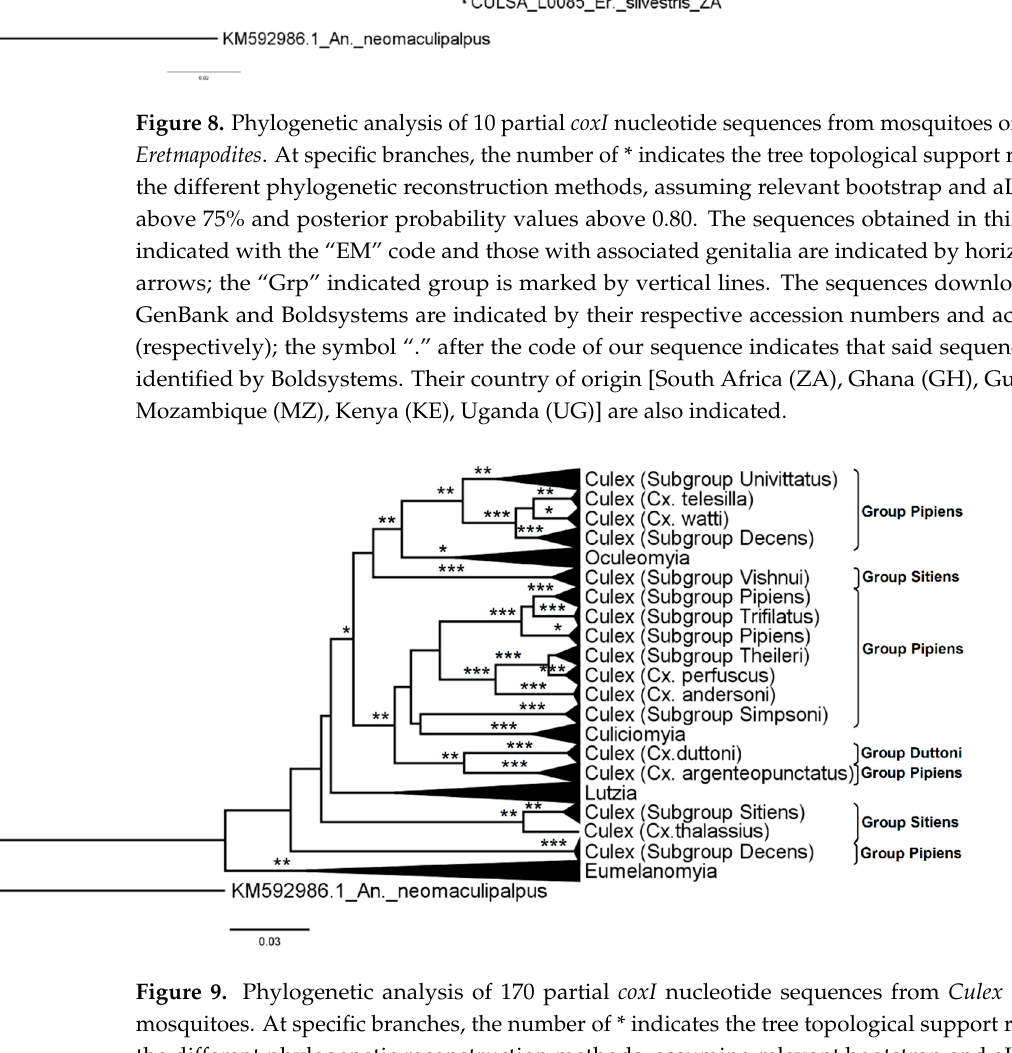
Figure 9. Phylogenetic analysis of 170 partial coxI nucleotide sequences from Culex and Lutzia mosquitoes. At specific branches, the number of * indicates the tree topological support revealed by the different phylogenetic reconstruction methods, assuming relevant bootstrap and aLRT values above 75% and posterior probability values above 0.80. In the collapsed branches there are species of the genus Lutzia and the subgenus and informal subgroups of the genus Culex ; the vertical lines mark the informal groups.